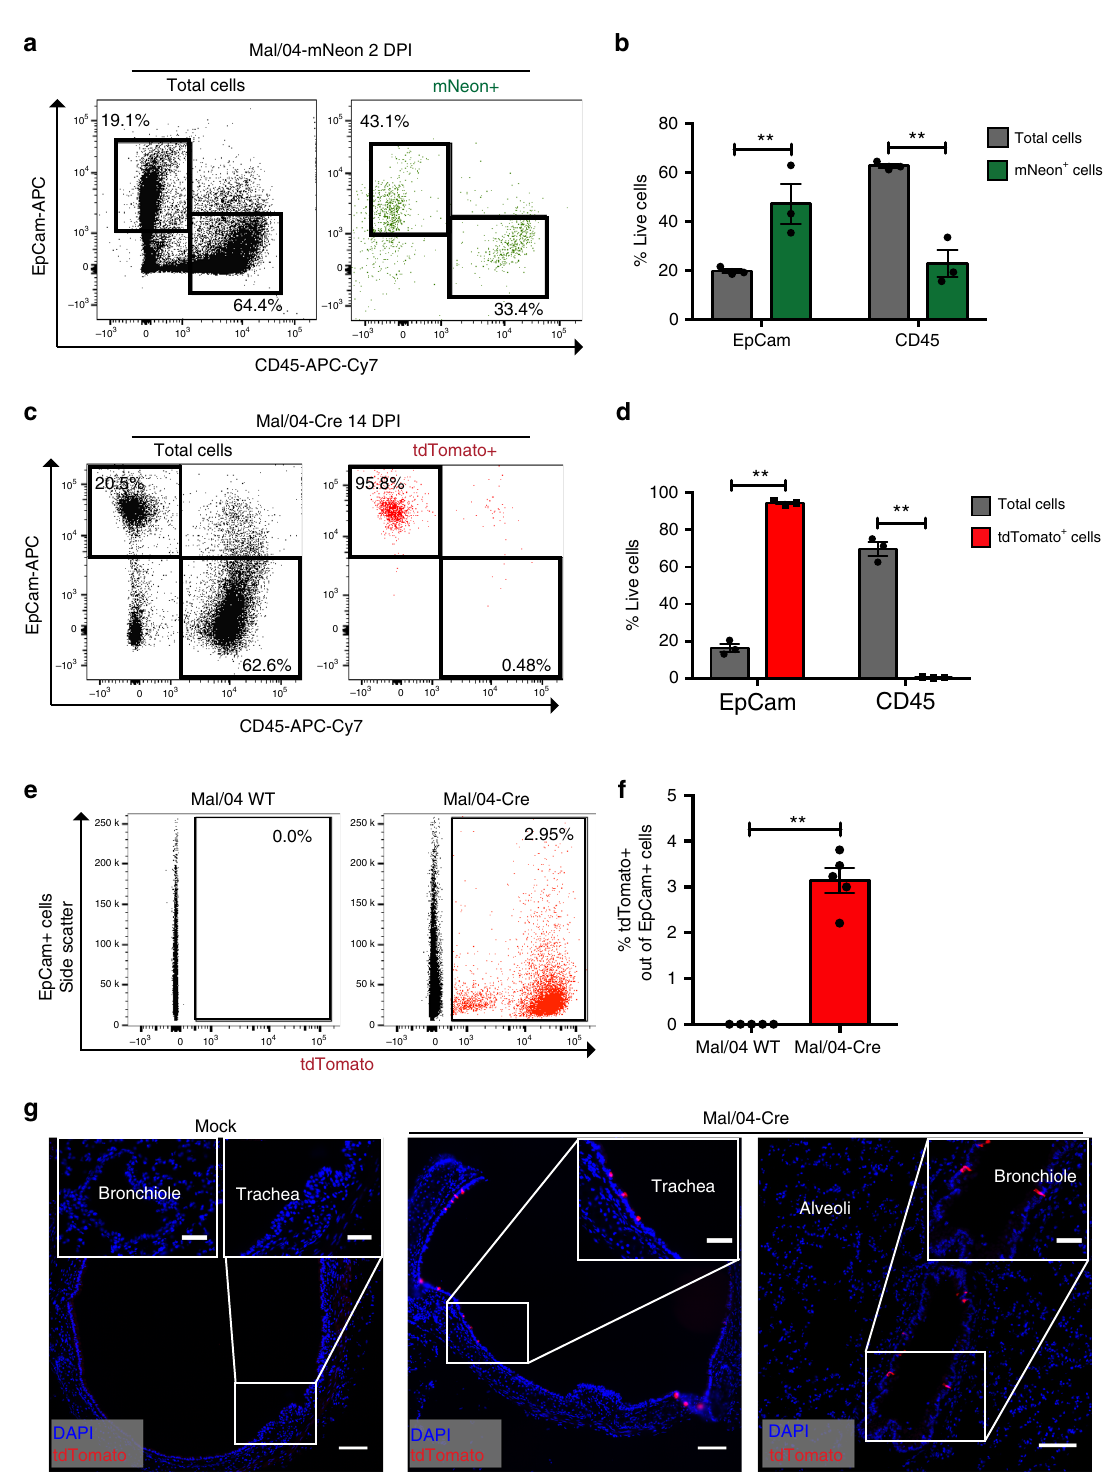
Fig. 2 Epithelial cells are infected by IBV and survive in the large airways of mice. a Flow cytometry of mNeon − (total cells) and mNeon + (infected cells) from the lungs of Mal/04-mNeon infected mice at 2 DPI, stained for EpCam (epithelial lineage) and CD45 (hematopoietic lineage). b Quanti fi cation of total and mNeon + infected cell expression of EpCam and CD45. n = 3 mice per sample, two-way ANOVA. c Flow cytometry of tdTomato − (total cells) and tdTomato + (survivor cells) from the lungs of Mal/04-Cre infected tdTomato Cre reporter transgenic mice at 14 DPI, stained for EpCam (epithelial lineage) and CD45 (hematopoietic lineage). d Quanti fi cation of total and tdTomato + survivor cell expression of EpCam and CD45. n = 3 mice per sample, two-way ANOVA. e Flow cytometry of epithelial (EpCam + ) tdTomato + survivor cells from Mal/04 WT and Mal/04-Cre infected mouse lungs. f Quanti fi cation of tdTomato + cells from murine lungs. n = 5 mice per sample, Student ’ s T -test. g Microscopy of 14 DPI Mock and Mal/04-Cre infected murine lungs with subpanels showing airways (bronchiole and trachea) and alveolar region. Scale bar = 100 μ m, inset scale bar = 50 μ m. S.E.M. was plotted to indicate variability around the mean for tested samples, * p ≤ 0.05, ** p ≤ 0.001, ns = not signi fi cant